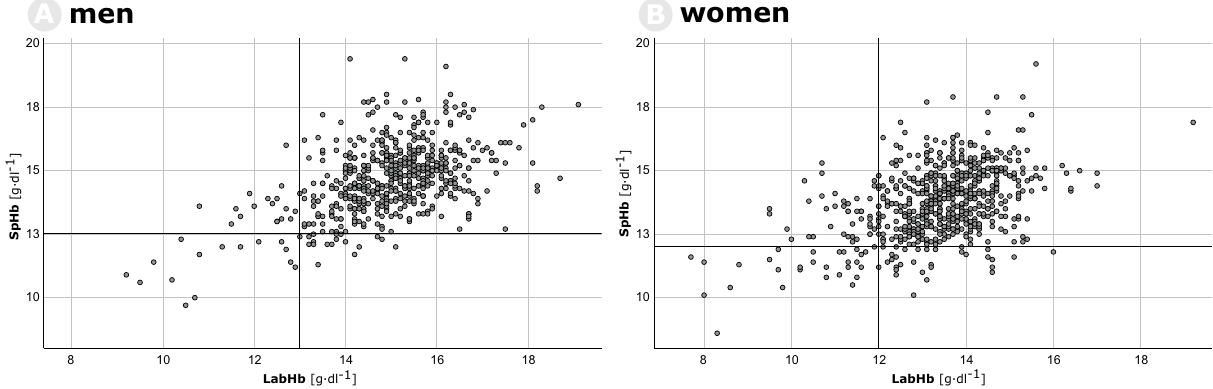
Figure 2. Scatterplots of LabHb (x-axis) and SpHb (y-axis) during preoperative evaluation. ( A ) Men and ( B ) women.